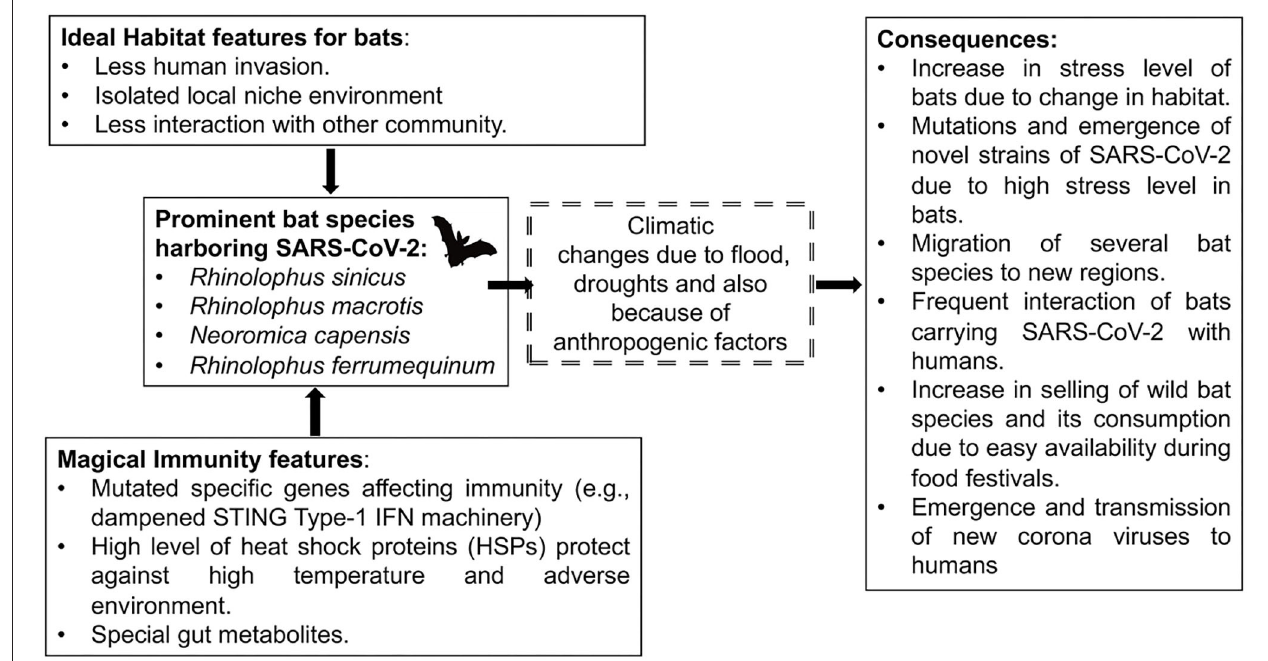
FIGURE 2 | Effect of climate change on bats and its habitat and its correlation with SARS-CoV-2 emergence. Many natural and anthropogenic interventions in the native habitat of bats had increased the probability of their contact with humans making mankind more susceptible to SARS-CoV-2. Climatic variations and anthropogenic factors have resulted in increasing stress responses in bats that carry various coronaviruses. Such changes in bat physiology have helped in creating novel mutants capable of infecting